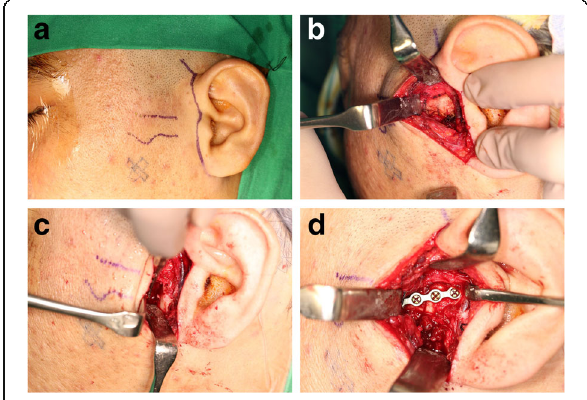
Fig. 5 a Drawing of incision line. b Exposure of zygomatic arch. c Osteotomy of zygomatic arch. d Reposition of the zygomatic arch fragment after resection of tumor